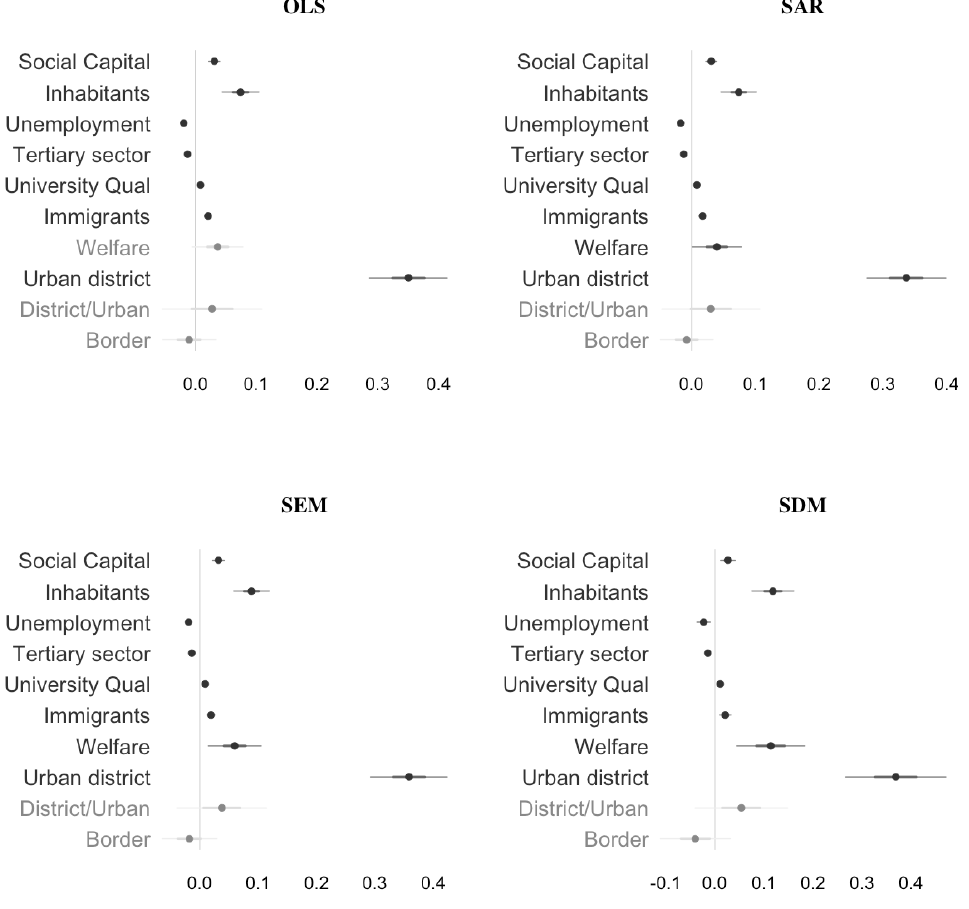
Figure 4: Illustrating regression results from Table 1 (dark grey denotes significant estimates)